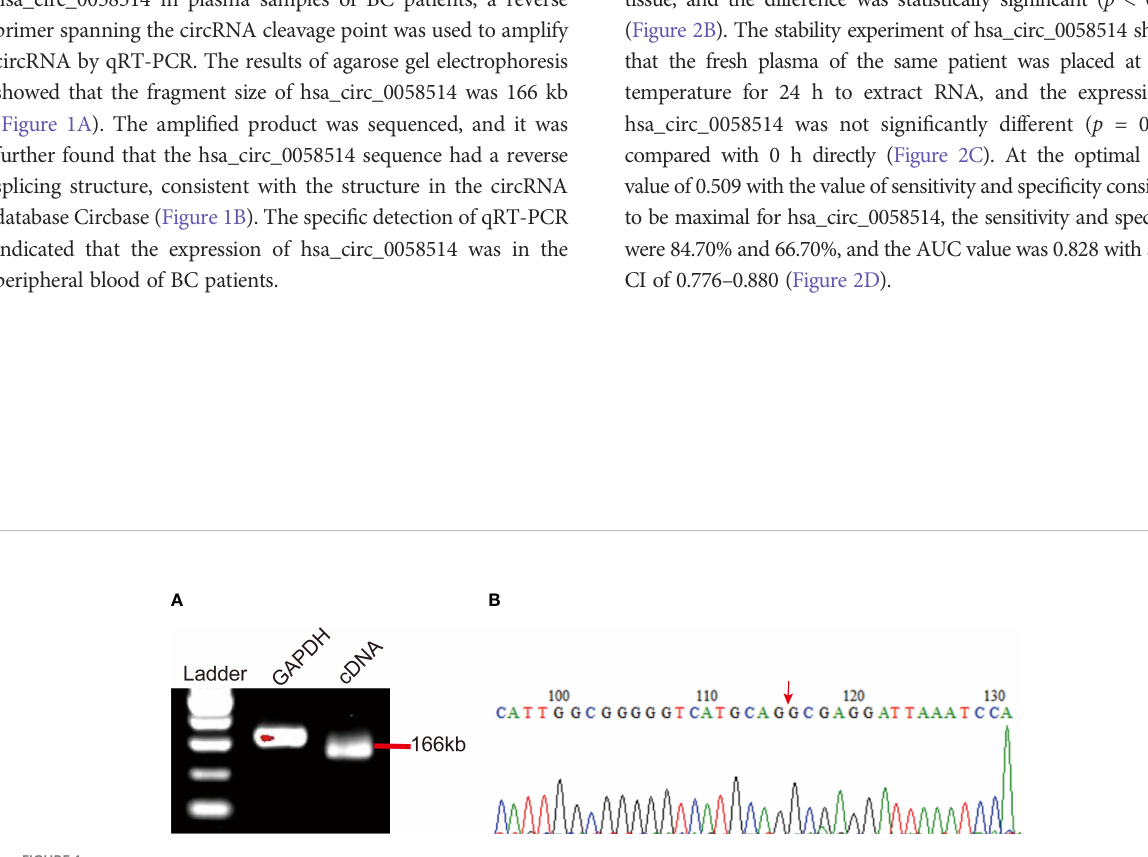
FIGURE 1 The identi fi cation and detection of hsa_circ_0058514 in BC patients ’ plasma. (A) PCR product of hsa_circ_0058514 in agarose gel electrophoresis. (B) The structure of hsa_circ_0058514 searched in